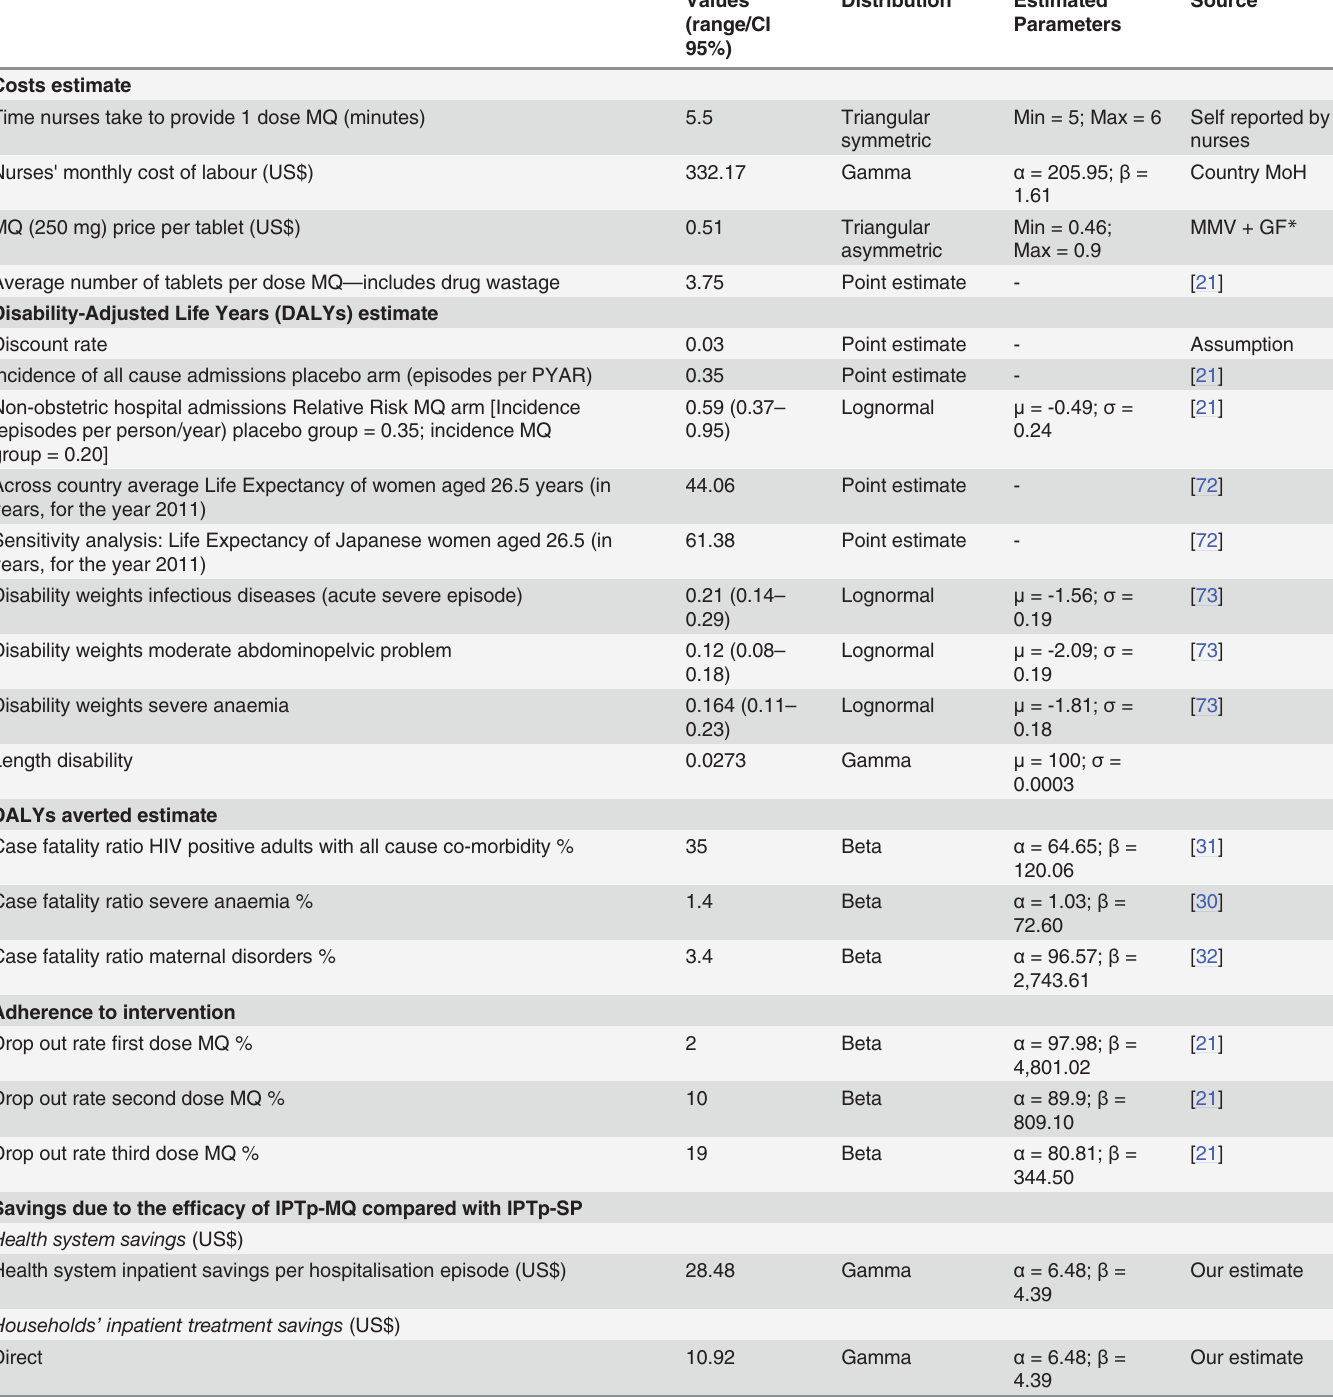
Table 2. Input variables of the threshold and cost-effectiveness analyses of IPTp-MQ compared with IPTp-placebo in HIV-positive pregnant